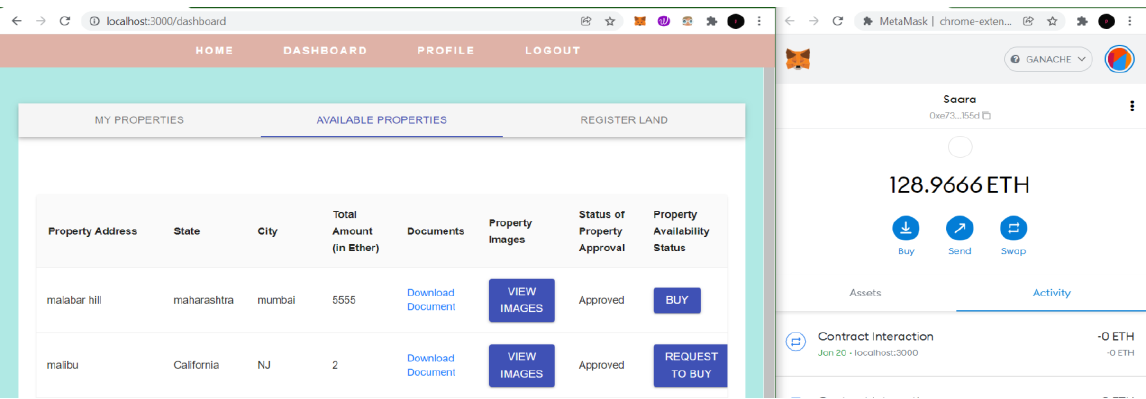
Fig 8: ` Property is visible in the ‘Available Properties’ section of the dashboard.